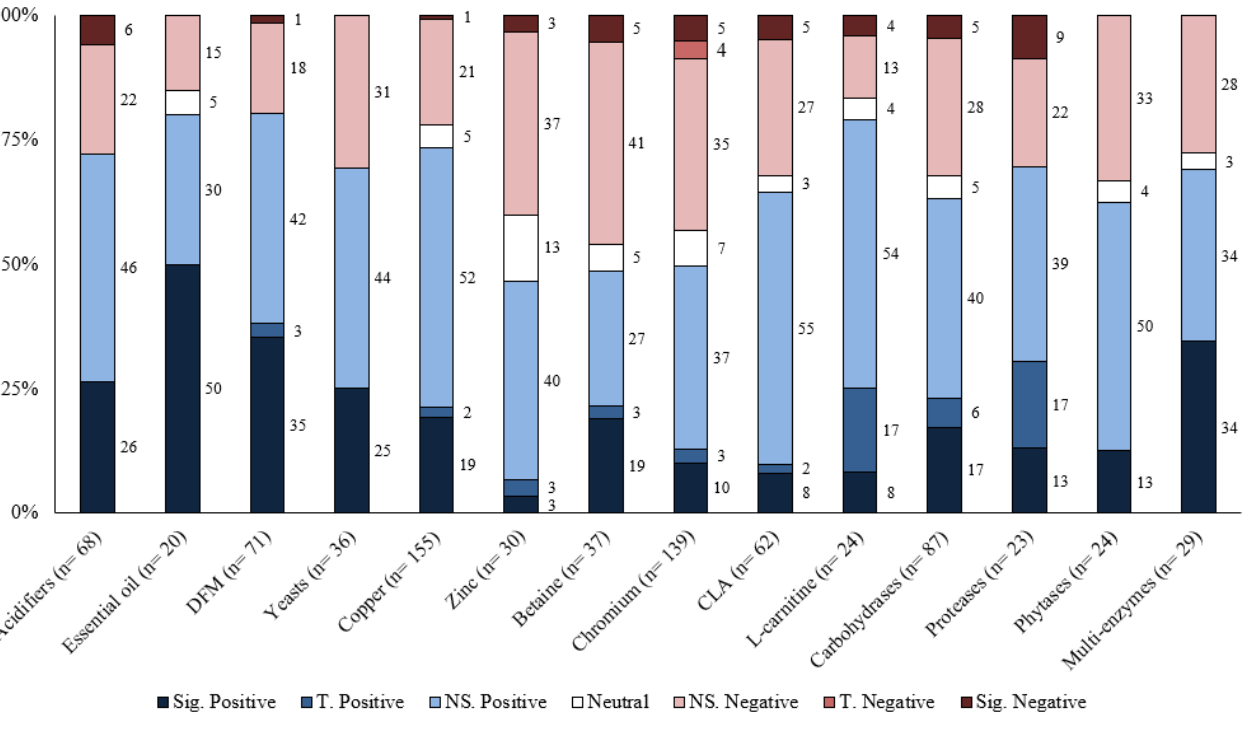
Figure 1. The distribution of results of various feed additives on ADG by significance level and direction. The comparison was significant (Sig.) if p ≤ 0.05, had a tendency (T.) if 0.05 < p ≤ 0.10, and was non-significant (NS.) if p > 0.10. difference of these comparisons.